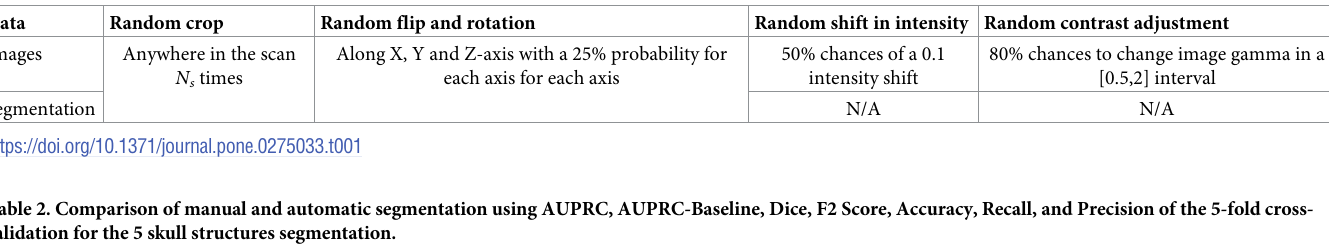
Table 1. Data augmentation transformations for the training.